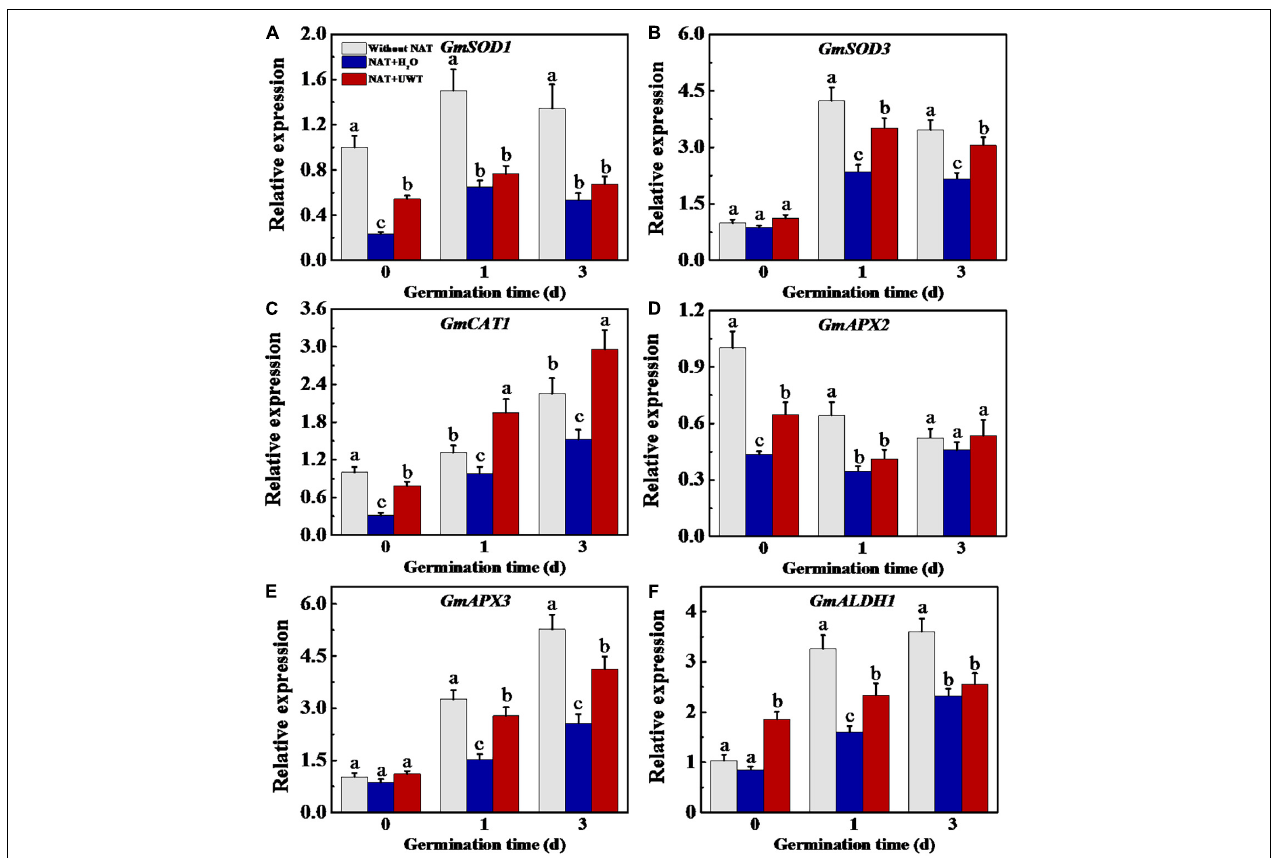
FIGURE 5 | Ultrasonic waves treatment increased the transcriptional levels of GmSOD1 (A) , GmSOD3 (B) , GmCAT1 (C) , GmAPX2 (D) , GmAPX3 (E) , and GmALDH1 (F) of aged soybean seeds during early germination. Without NAT, fresh seeds without naturally aging treatment (NAT); NAT + H 2 O, Seeds stored for 12 months with H 2 O; NAT + UWT, NAT seeds with UWT. The RT-PCR assays were performed with four independent biological replicates and three technical replicates. Different lowercase letters in the same column indicate significant differences between different treatments ( p <